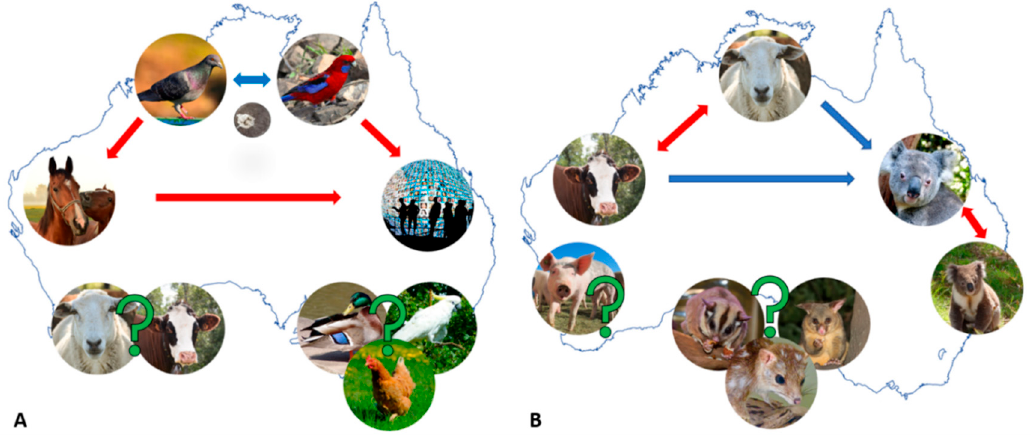
Figure 1. Schematic representation of postulated epidemiology and cross-host transmission of the chlamydial infections in Australia. ( A ) Postulated cross host transmission of Chlamydia psittaci (Cps) infections and ( B ) Postulated cross host transmission of Chlamydia pecorum (Cpec) infections. Red arrows indicate the most likely cross-host transmission routes supported by molecular investigations (e.g., in A , Cps from birds or horses to humans and in B , Cpec between koalas or livestock). Blue arrows indicate likely (hypothesised) routes of cross-host transmission (e.g., in A , Cps between birds and in B , livestock Cpec to koalas) and green question marks indicate scarce reports in the denoted hosts and mainly unknown epidemiology.